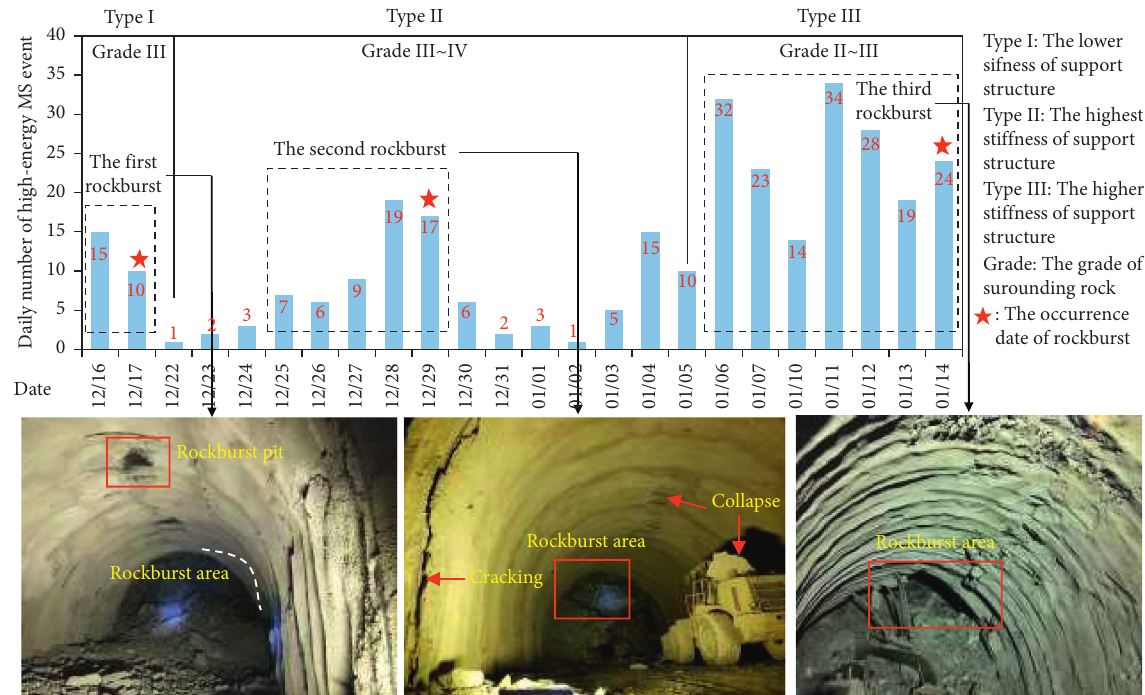
Figure 3: The record of the rockburst evolution during construction in the Micangshan tunnel (2017–2018).